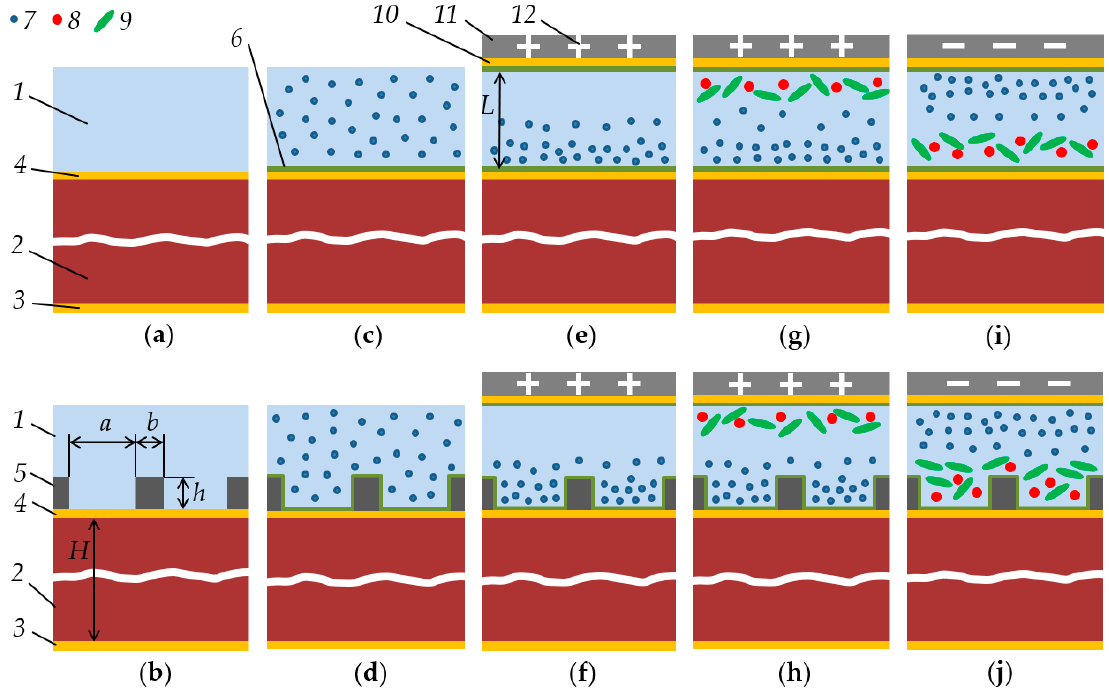
Figure 2. Model development of quartz resonator with planar ( a , c , e , g , i ) and structured ( b , d , f , h , j ) top surfaces with direct solid/liquid contact ( a , b ) or coated with a thin surface passivation layer ( c – j ) and loaded by liquid in different cases: ( a , b ) Homogeneous liquid; ( c , d ) liquid with protein particles of one type that are evenly distributed throughout the liquid volume; ( e , f ) liquid with charged particles of one type that are concentrated near the quartz surface due to an external electric field; ( g , h ) liquid with several types of particles separated in external electric field made by positively charged additional top electrode, which concentrate positively charged particles near the quartz surface and sorts out negatively charged particles; ( i , j ) liquid with several types of particles separated in external electric field made by negatively charged additional top electrode, which concentrates negatively charged particles near the quartz surface and sorts out positively charged particles. Schematic model of sensor structure consists of measured liquid (1); quartz crystal resonator (2) of H thickness; bottom electrode (3) under alternating probing potential; top grounded electrode (4); set of protrusions (5) of h height, a distance and b width, placed on the top electrode surface; surface passivation layer (6); positively (7) and negatively (8, 9) charged protein particles of different mass and morphology; addition electrode (10) attached to the L height ceiling of the microfluidic channel (11) and charged (12). Geometrical proportions of the figures are not observed for reasons of visual clarity (e.g. particles must be smaller in reality).